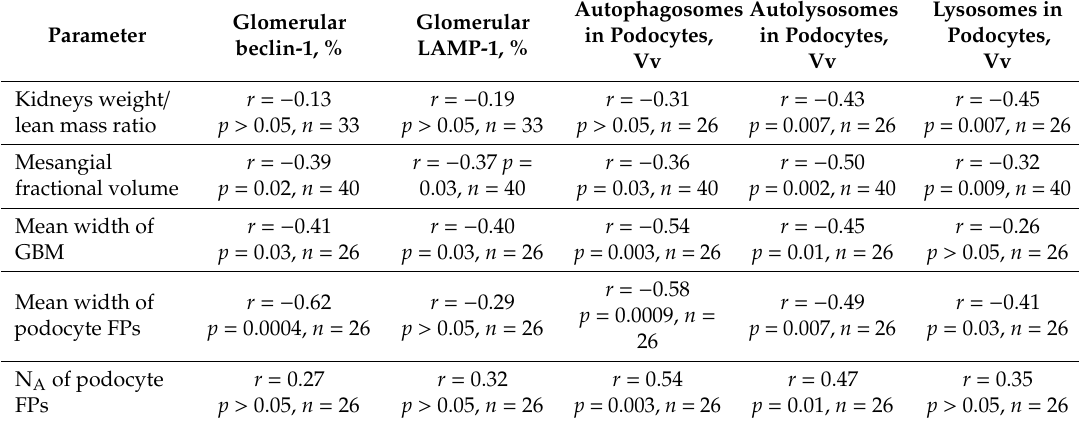
Table 7. Relationships between glomerular and podocyte autophagy characteristics and other parameters of renal morphology.